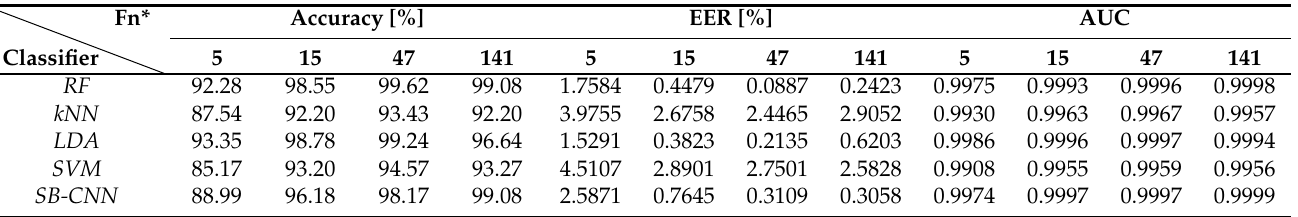
Table 1. Accuracy, EER, and AUC of Discriminative Classification Models According to Four Different Numbers of